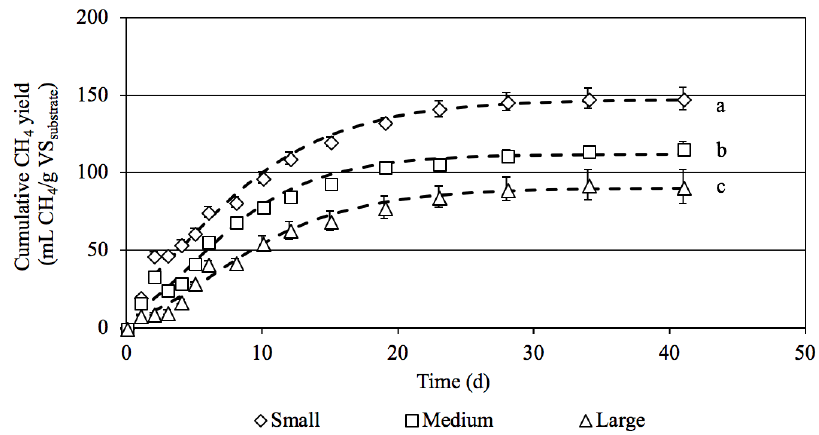
Figure 3. Cumulative methane yield from Napier grass at different sizes (symbols—observed data, dashed lines—predicted data with the Gompertz equation).